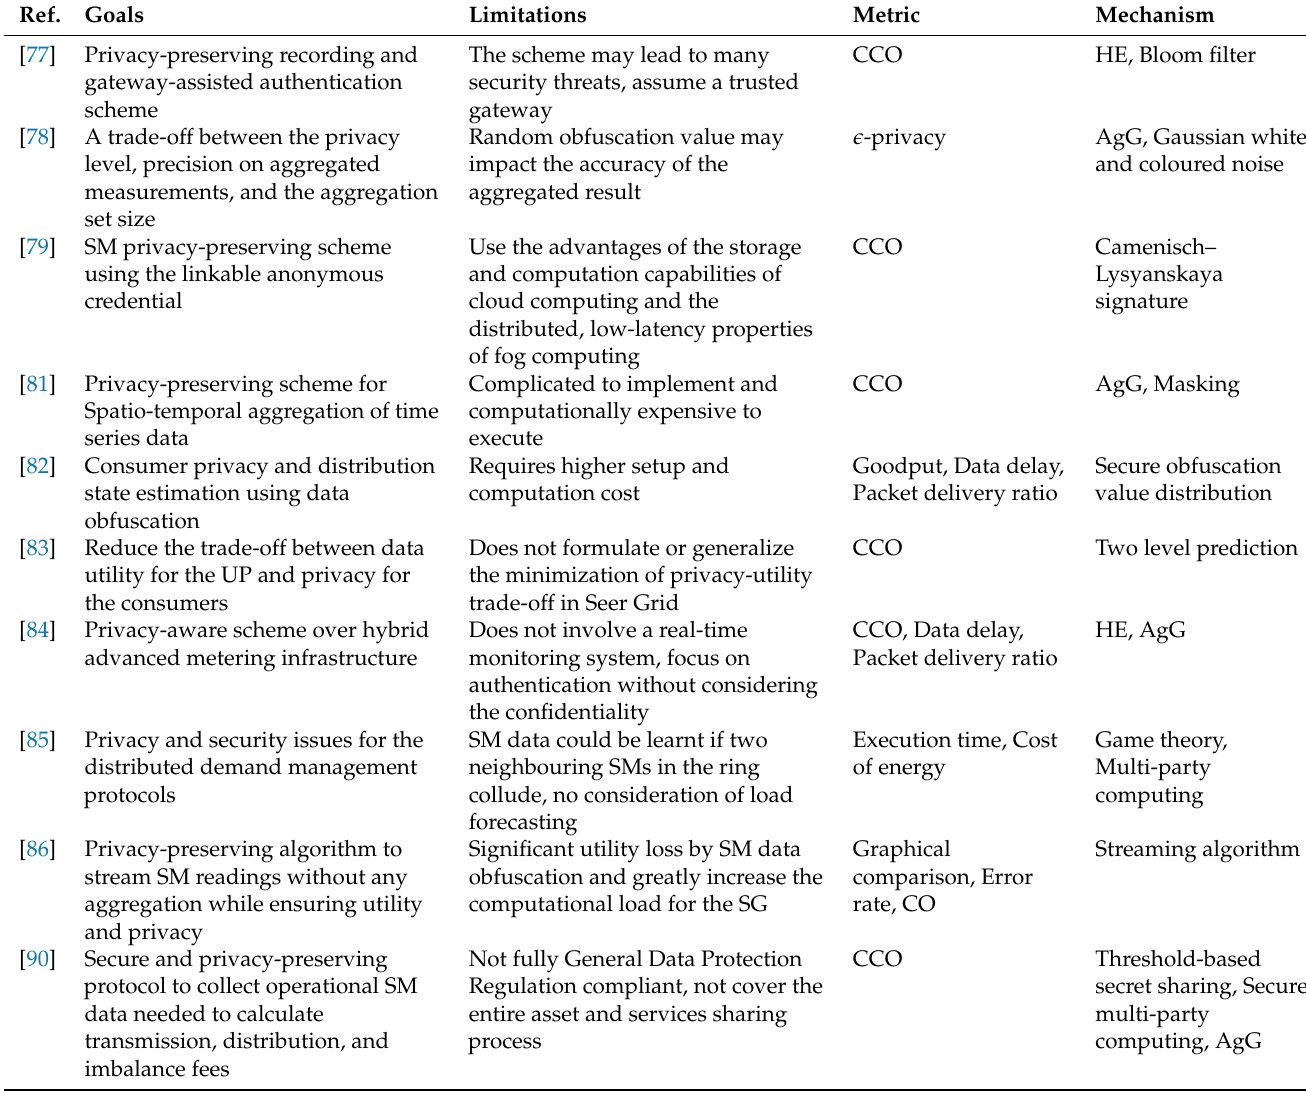
Table 4. Summary of SM privacy-preservation techniques for communication protocols against weak adversaries without